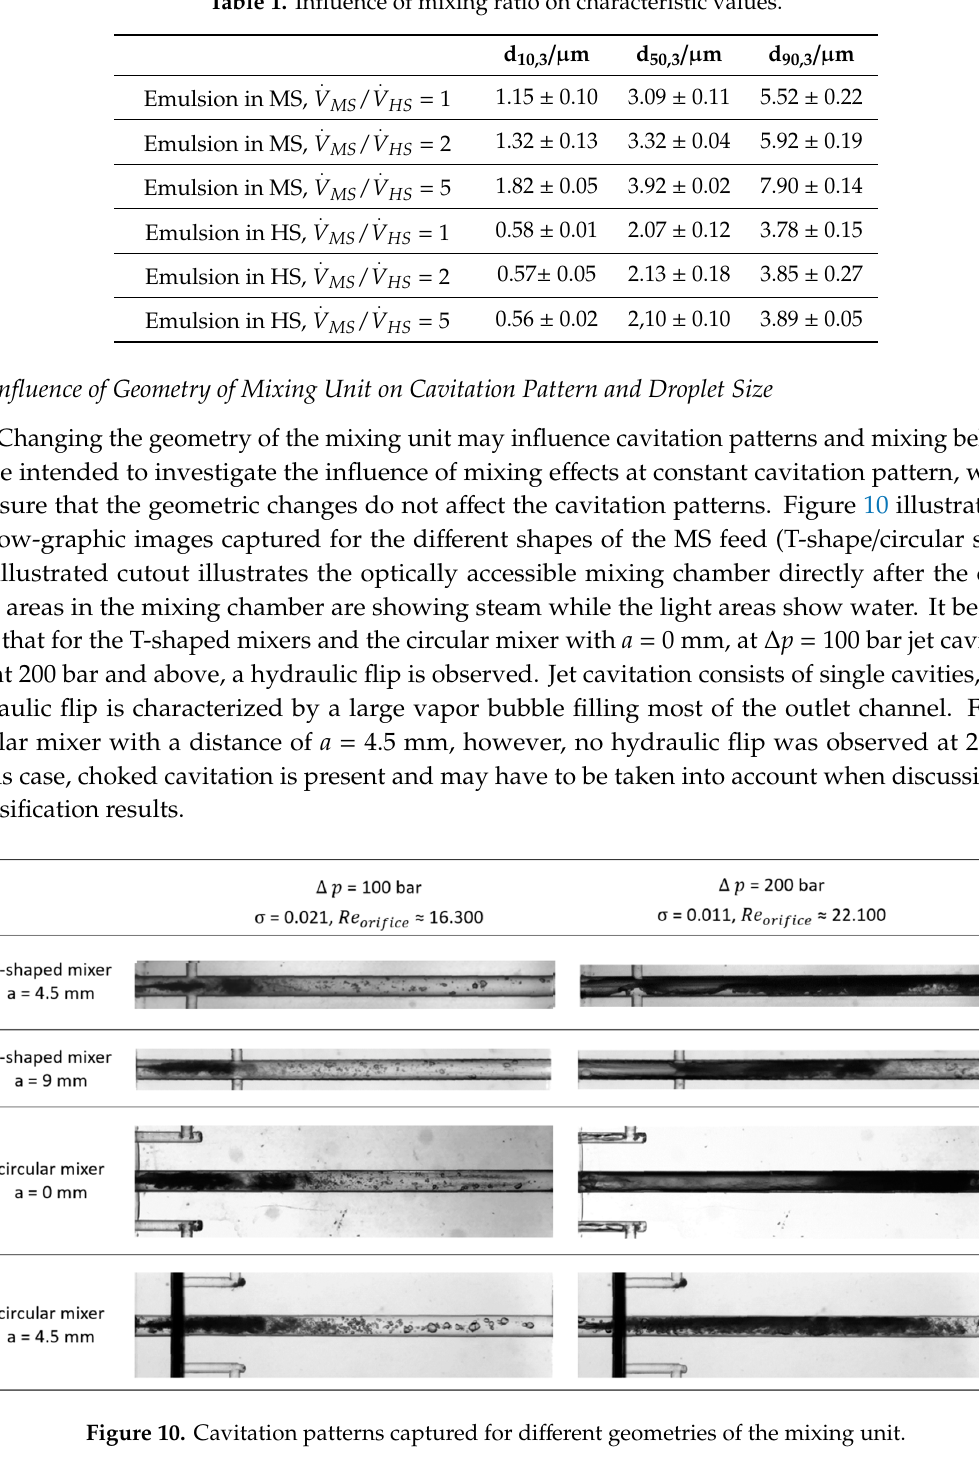
Table 1. Influence of mixing ratio on characteristic values.